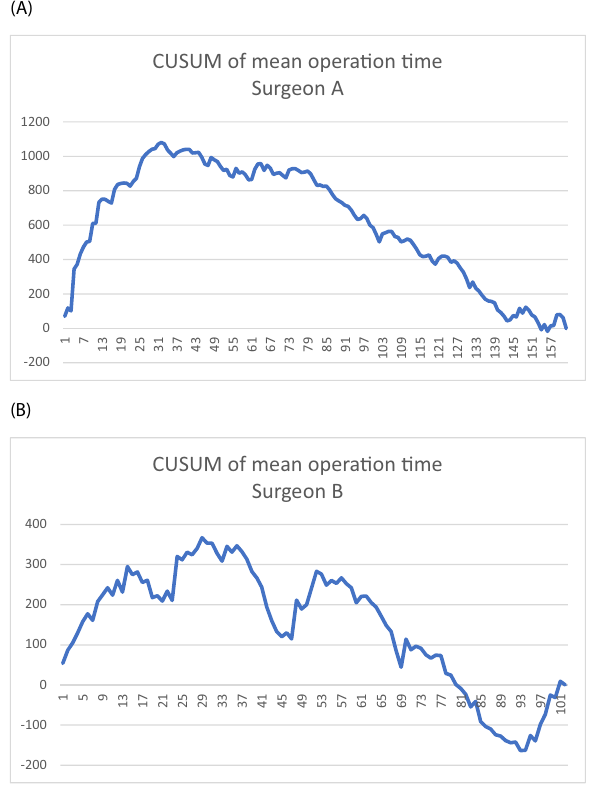
Figure 3. CUSUM of mean operation time. The x-axis indicates the number of procedures performed. The y-axis indicates the cumulative surgery time (minutes) compared to the mean surgery time. When the performance time is longer or shorter than the mean surgery time, the graph rises or falls with the absolute difference in minutes. Because the rising or falling of the graph is based on the mean surgery time, the graph ends at 0 min. (A) Vaginal pelvic reconstruction without mesh performed by surgeon A; operation time dropped after 32 procedures. (B) Vaginal pelvic reconstruction with mesh performed by surgeon B; operation time dropped after 37